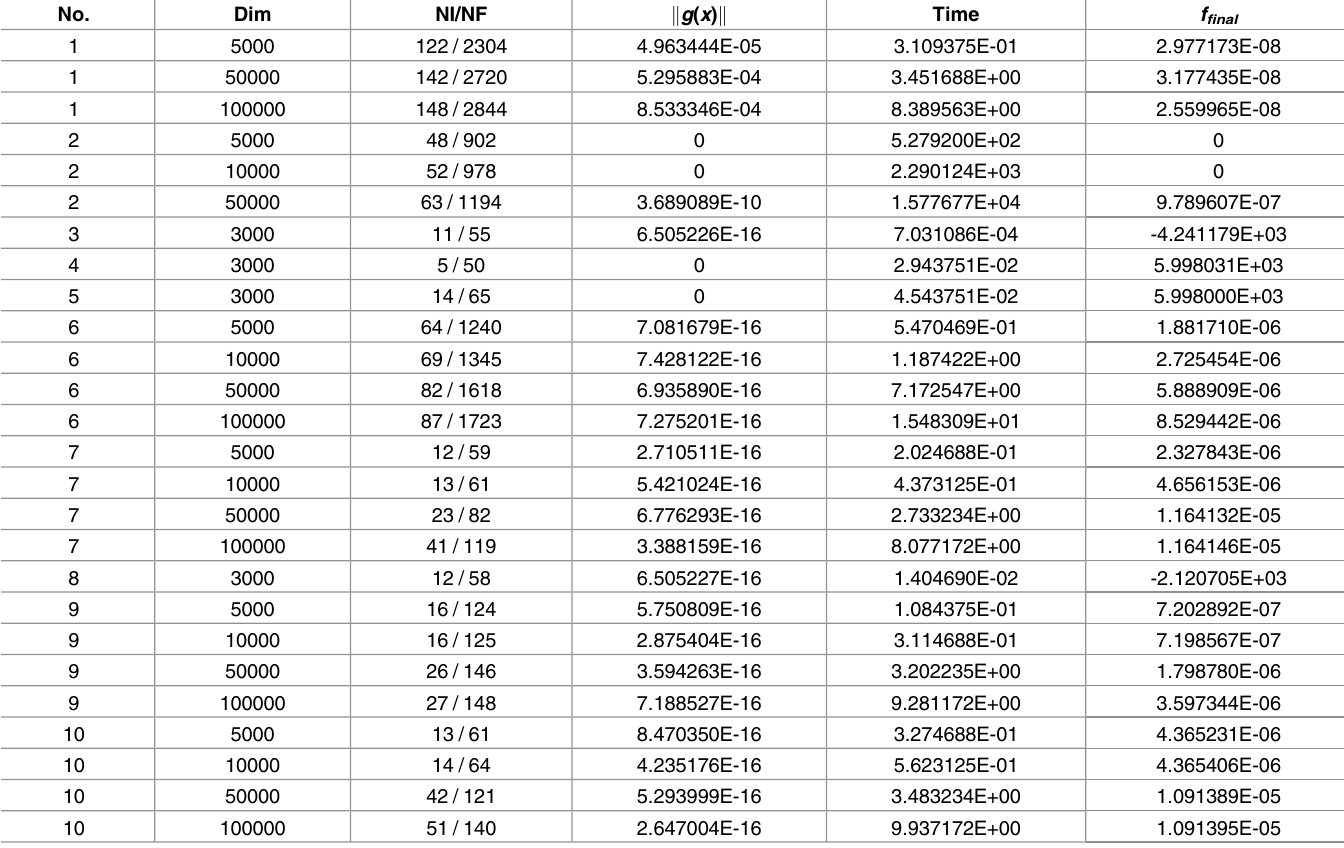
Table 2. Test results for Algorithm 4.1.